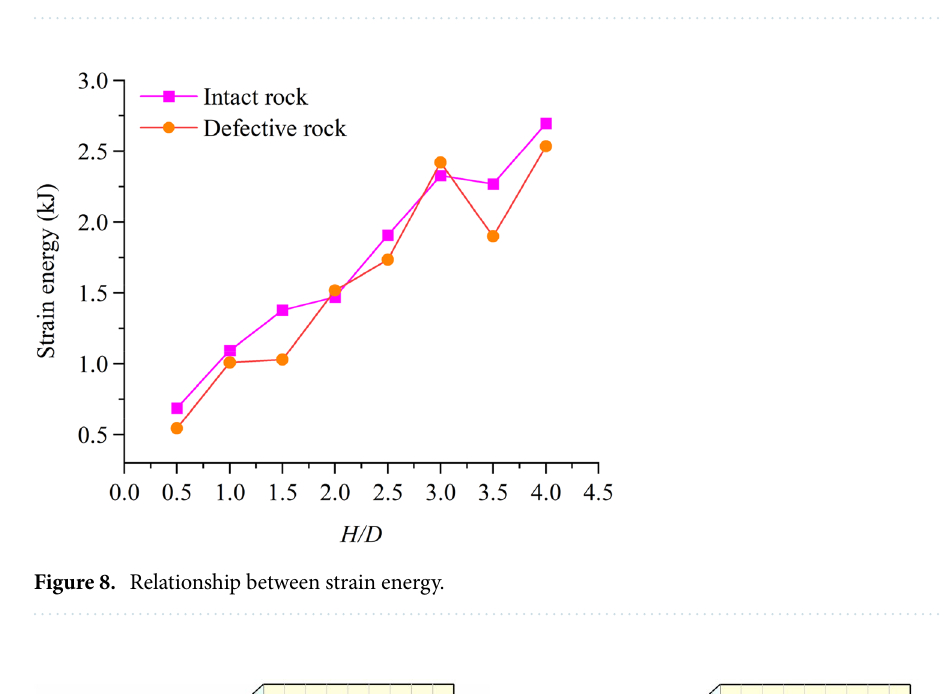
Figure 7. Strain energy curve of rock sample ( a ) Intact rock ( b ) Defective rock.